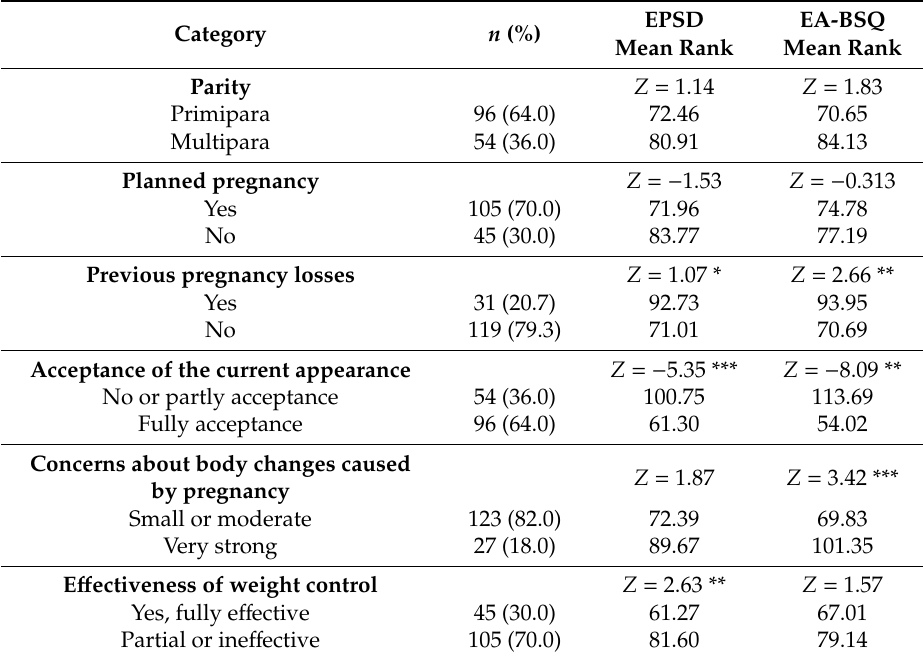
Table 2. Mean ranks of prenatal depression (EPSD) and the evaluation of appearance (EA-BSQ) in pregnant women with di ff erent obstetric factors and body image perception ( N = 150). Category n